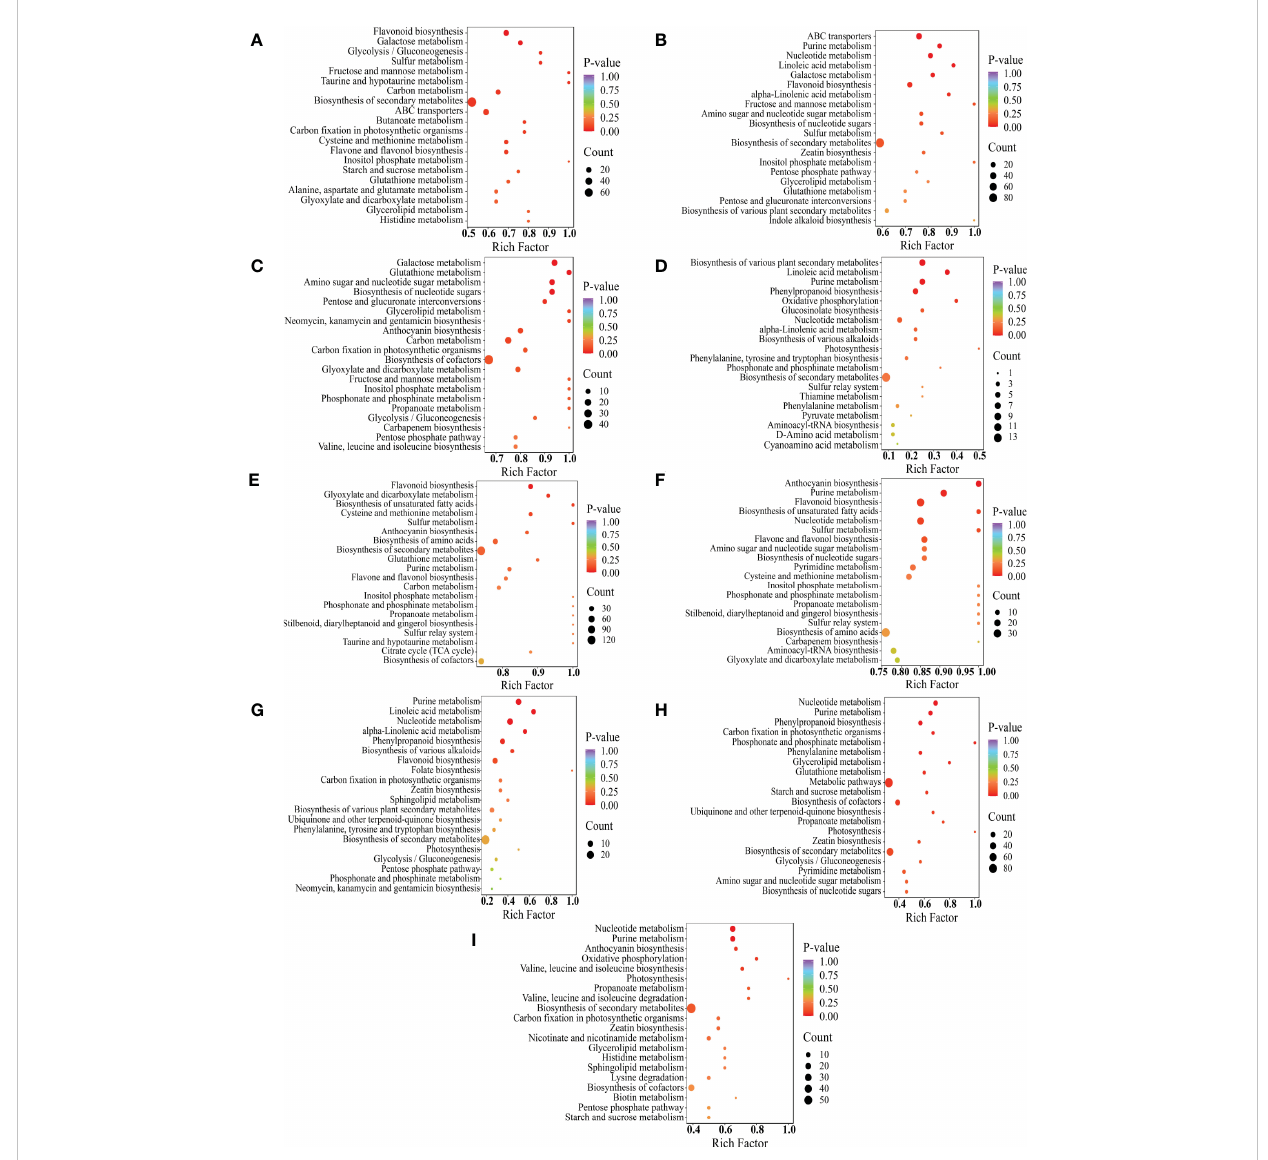
FIGURE 6 KEGG enrichment of differential metabolites between the comparison groups, Y-R vs Q-R, Y-RP vs Q-RP, Y-RS vs Q-RS, Q-R vs Q-RP, Q-R vs Q-RS, Q-RP vs Q-RS, Y-R vs Y-RP, Y-R vs Y-RS, and Y-RP vs Y-RS (A – I) . Each bubble in the plot represents a metabolic pathway whose abscissa and bubble size jointly indicate the magnitude of the impact factors of the pathway. A larger bubble size indicates a larger impact factor. The bubble colors represent the p -values of the enrichment analysis, with darker colors showing a higher degree of enrichment. (For interpretation of the references to color in this fi gure legend, the reader is referred to the web version of this